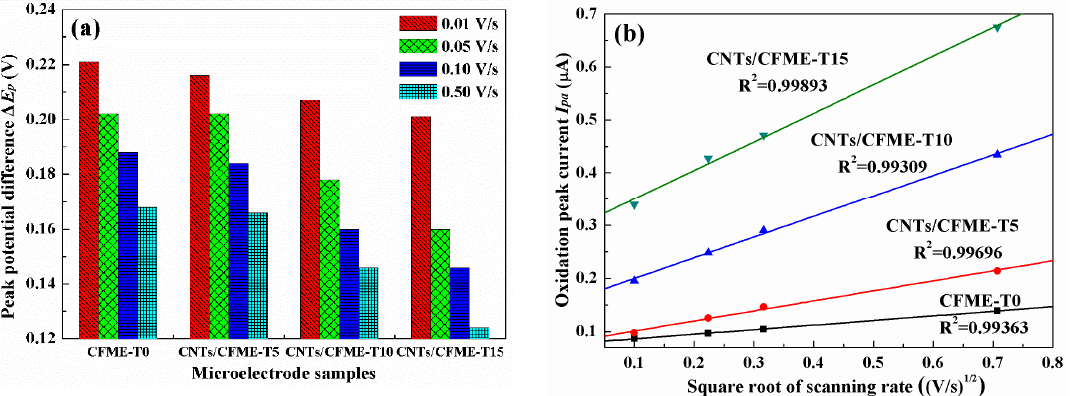
Figure 7. ( a ) ∆ E p values of microelectrodes at different scan rates; ( b ) I pa values versus the square root of scanning rate.